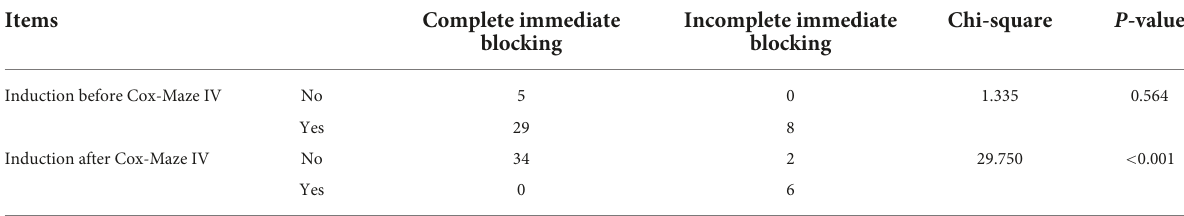
TABLE 3 Correlation between incomplete conduction blocking of ablation lines with atrial fibrillation (AF) inducibility before and after Cox-Maze IV in the Electrophysio-Maze group. Items